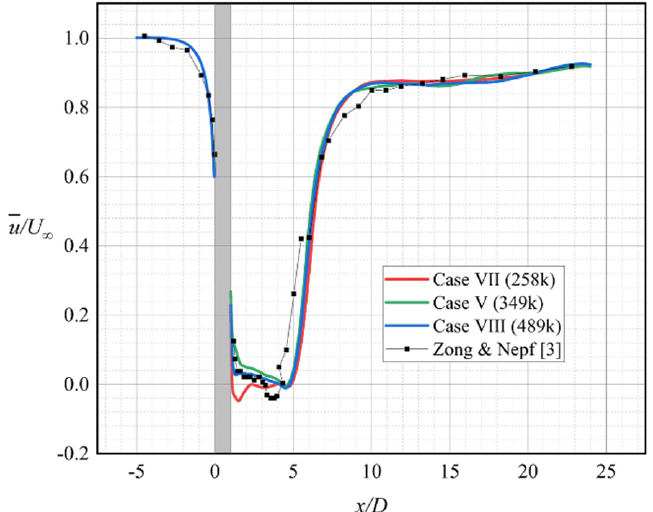
Figure 3. The simulation results of case V, case VII, and case VIII are compared with those of Zong and Nepf [3]. The diameter of the vegetation patch is 22 cm, and the data in the figure are the centerline ( y = 0) longitudinal mean velocity ( u ) distribution. The gray part indicates the internal area of vegetation patches. Table 3. Some results of cases V, VII, and Ⅷ for grid independence validation, where 𝐿 (cid:2869) is defined in Section 3.